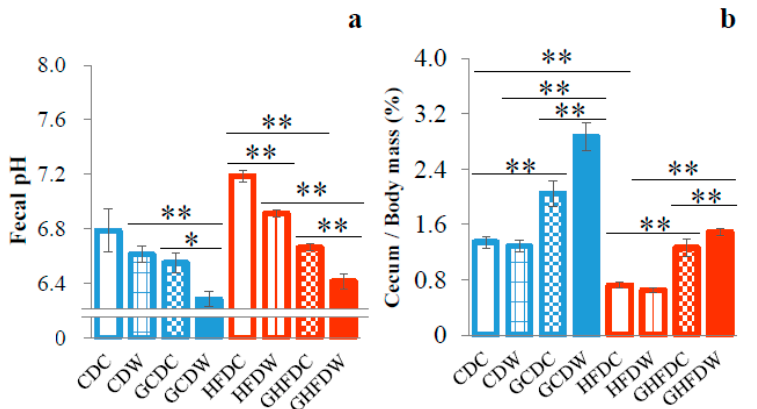
Figure 3. The supplemental effect of wheel running on fecal pH and cecum mass in PHGG intake mice under CD and HFD feeding. Fecal pH at 6 weeks ( a ) and cecum mass ( b ) showed as percentage of body mass after 10 weeks. The values were expressed as the mean ± S.E.M. * p < 0.05 and ** p < 0.01.